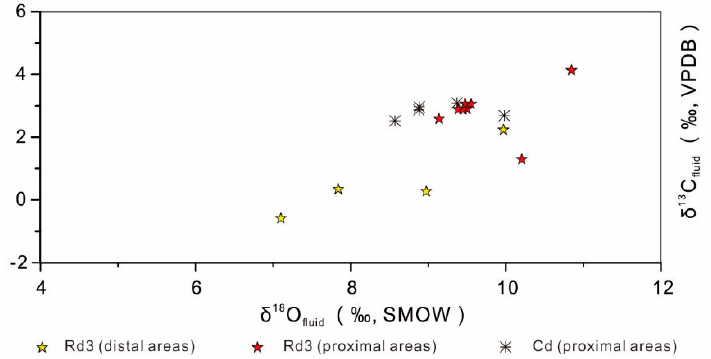
Figure 13. Cross-plot of δ 13 C fluid and δ 18 O fluid values of Rd3 and Cd dolomites, calculated from the δ 18 O and δ 13 C values of the carbonate minerals and the average temperatures based on homogenization temperatures of FIAs [38].